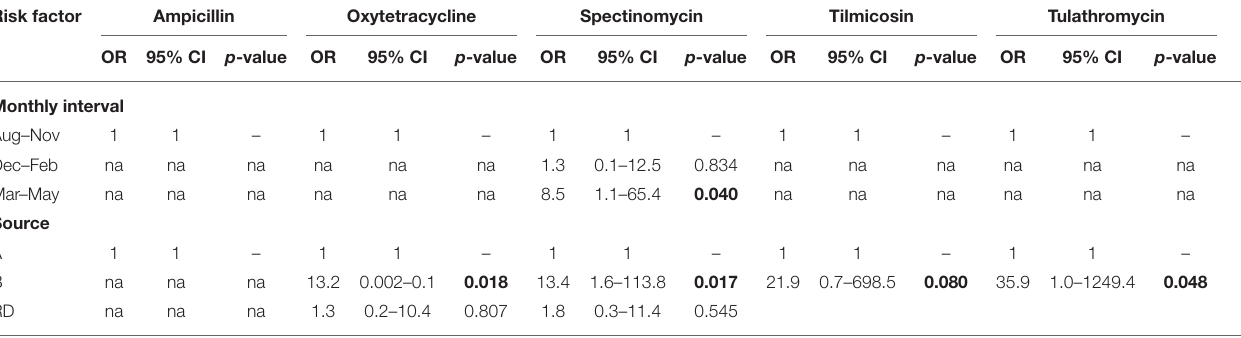
TABLE 6 | Significant results obtained from logistic regression of antimicrobial resistant Pasteurella multocida from beef-type cattle upon feedlot arrival. Risk factor